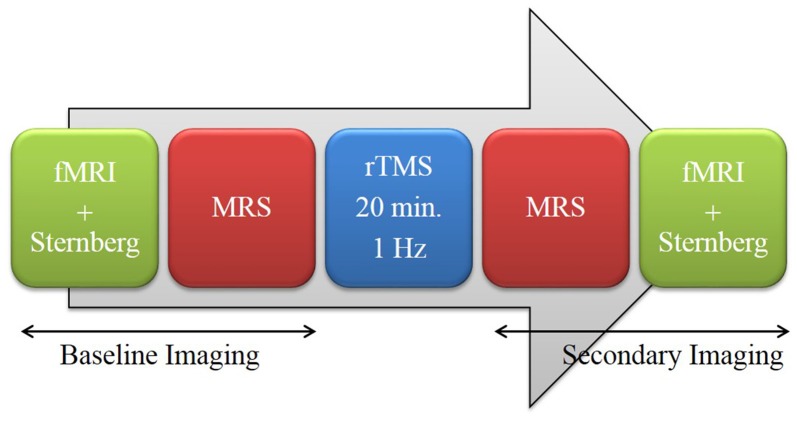
Procedural Outline.